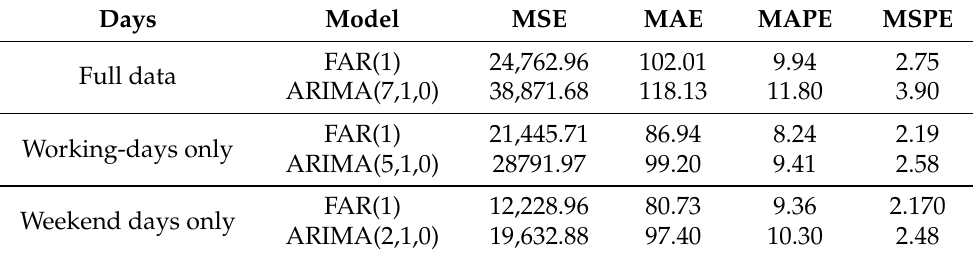
Table 2. Accuracy statistics for a one-day ahead out-of-sample traffic flow